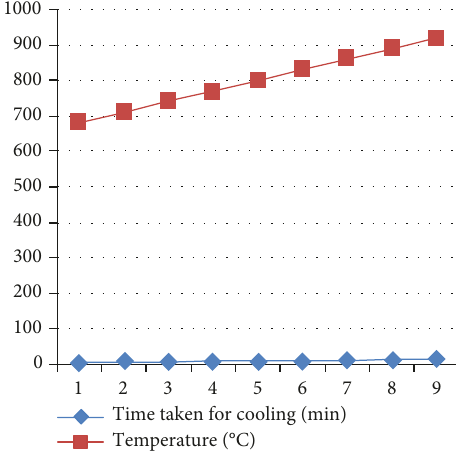
Figure 12: Graph between temperature and cooling